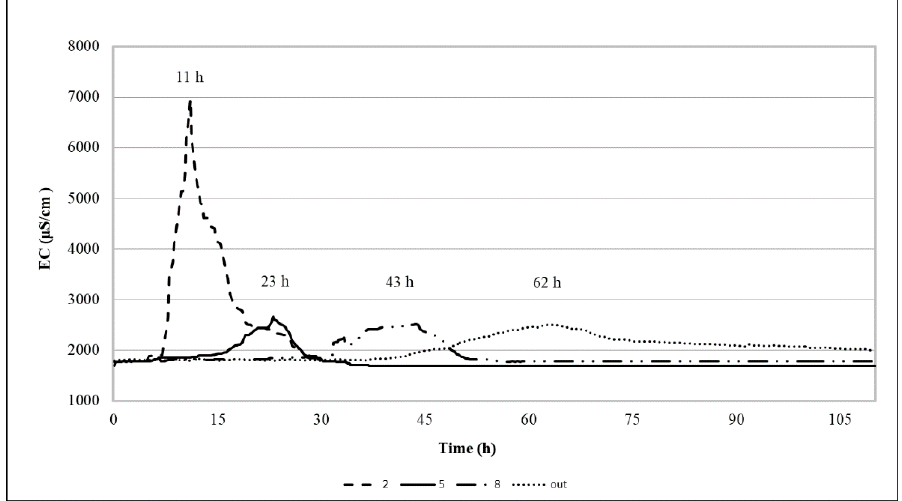
Figure 6. Electrical conductivity ( EC ) variation ( µ S cm − 1 ) along the central path of the HSTW bed (2-5-8) and at the outlet.